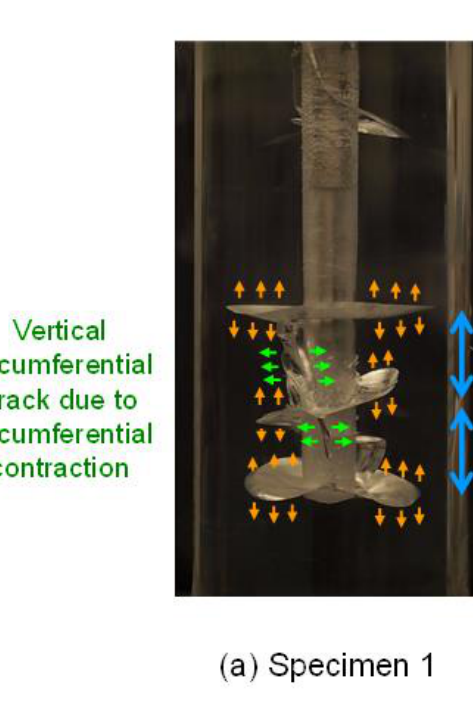
Figure 8. Crack morphology and driving thermal tensile stresses. ( a ) Specimen 1 after 6 minutes’ flow and ( b ) Specimen 3 at the end of